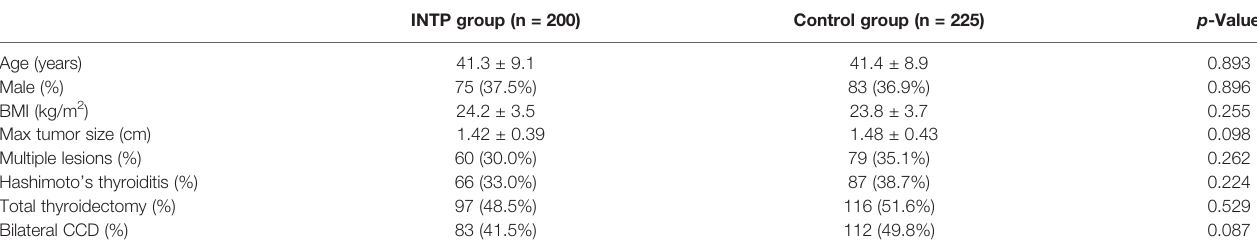
TABLE 3 | Clinicopathologic characteristics in transoral endoscopic